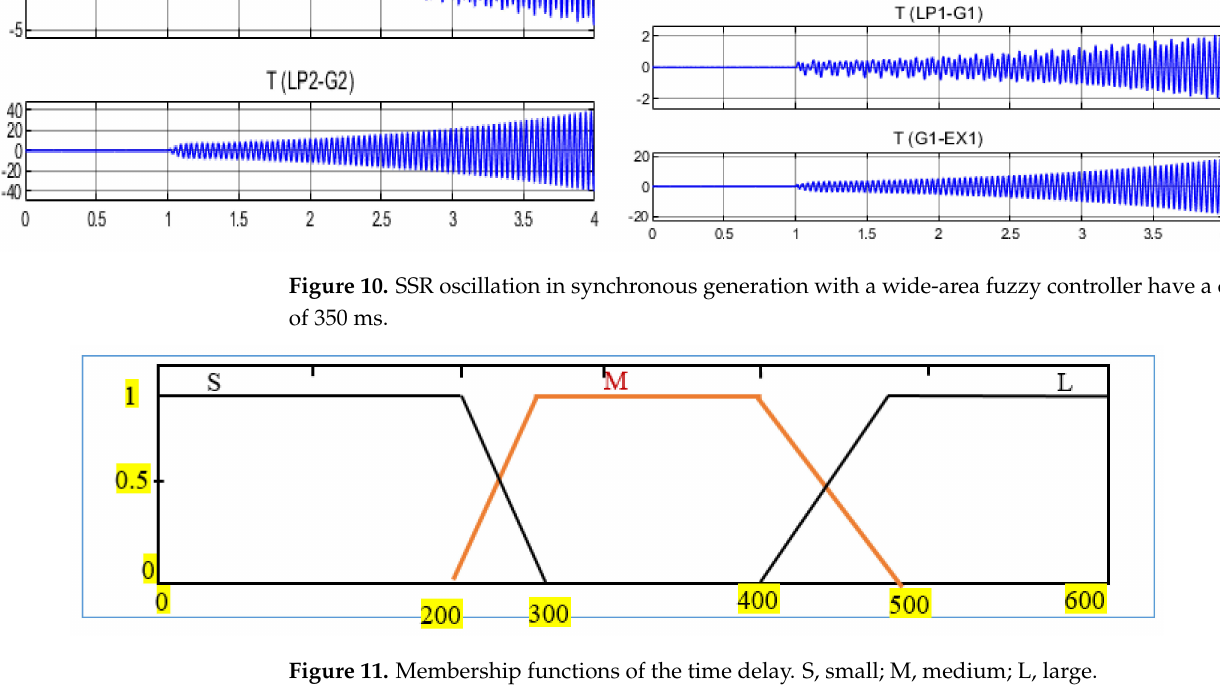
Figure 11. Membership functions of the time delay. S, small; M, medium; L, large.